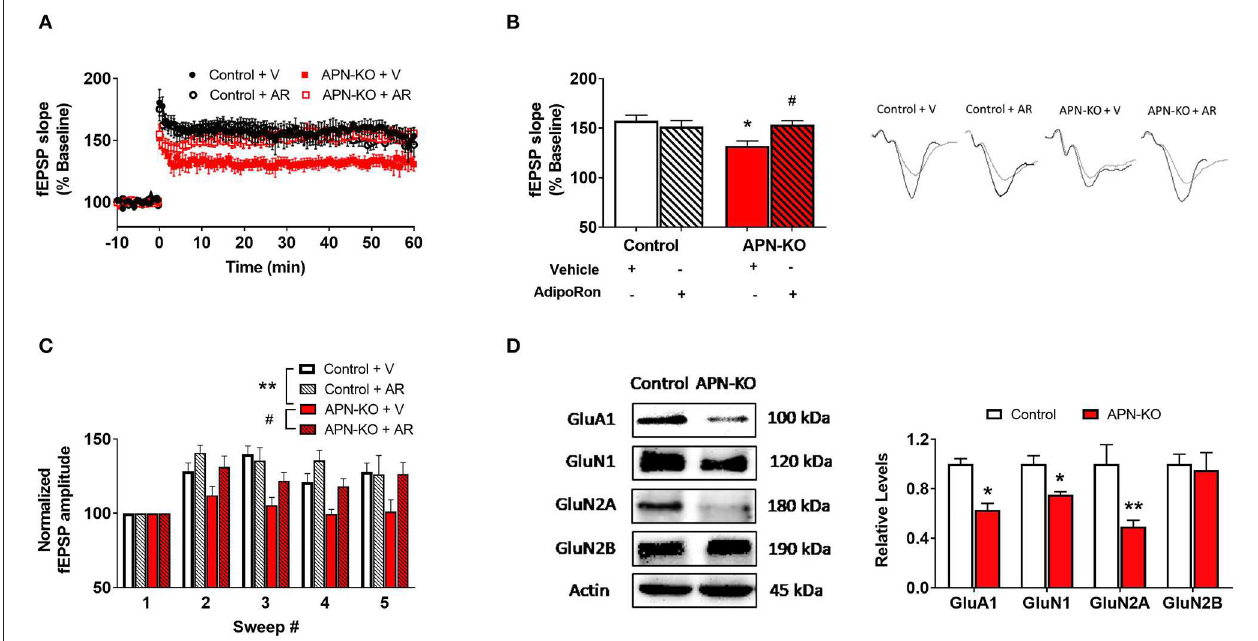
FIGURE 4 | Deficits in LTP in APN-KO mice are associated with reduced levels of glutamatergic receptor subunits. For (A–C) , hippocampal slices were prepared from Control and APN-KO mice and incubated for 2-h in either ACSF containing 0.03% DMSO [Vehicle (V)] or ACSF containing 15 µ M of AdipoRon and 0.03% DMSO [AdipoRon (AR)] prior to recording. (A) LTP graph represents fEPSP slope before and after induction by TBS. (B) LTP bar graph shows fEPSPs recorded during the time period 50–60min following TBS induction normalized to baseline levels, and traces before and after LTP induction are shown. (C) Sweep analysis computed by normalizing the amplitude of the first fEPSP of sweeps 2–5 with the amplitude of the first fEPSP of sweep 1 during LTP induction. (D) Representative immunoblot showing GluA1, GluN1, GluN2A, and GluN2B relative levels normalized to beta-actin in total hippocampal lysate. Forty micrograms of protein were loaded per lane. Bars represent mean ± SEM; *indicates significant difference between APN-KO and Control, # indicates significant difference between APN-KO and APN-KO + AR; */ # p < 0.05, ** p < 0.01; for (A–C) , n = 5–6 slices from 4 mice per group; for (D) , n = 3–4 mice per group; Tukey’s post hoc test was used for multiple comparisons.